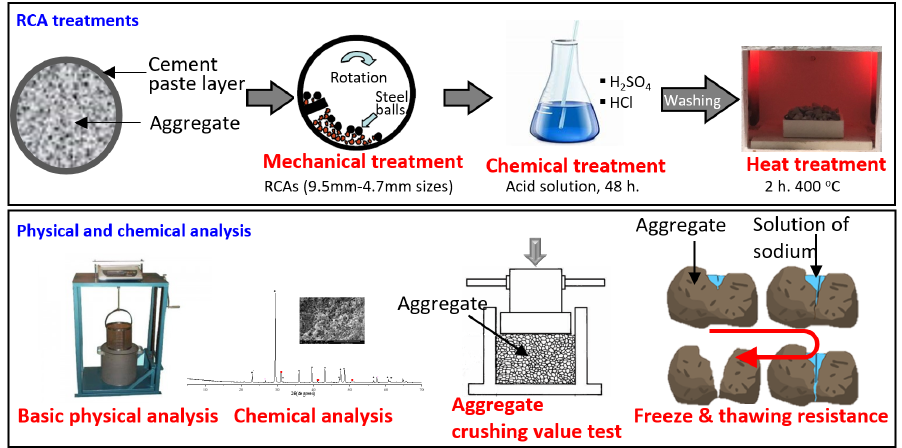
Figure 2. Treatment processes and test programs of this